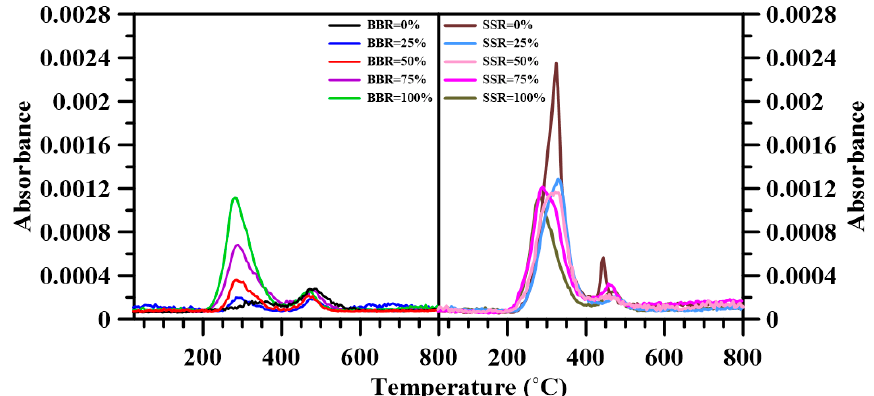
Figure 10. Evolution of CH 4 for various sludge-coal and sludge-shiitake ratios in TGA-FTIR. The CO emission profiles for the individual fuels and their blends are shown in Figure 11. Only one absorption peak was observed for coal and the sludge-coal blends. In contrast, all profiles of the sludge-shiitake blends showed two peaks, in the temperature ranges of 275–400 °C and 425–575 °C, respectively. The first CO peak for sludge was observed at about 341 °C and the second one was observed at about 495 °C. The CO generation of stage 1 and stage 2 was attributed to the decomposition of the volatiles and decarbonylation reaction, respectively. Adding sludge to the blends reduced the absorption value of their peak, which is consistent with the results in Table 5. BBR = 75% yielded the lowest value (0.078). However, adding shiitake to the sludge-shiitake blends increased the CO emission in stage 1, which was compensated with a reduction in CO in stage 2. Overall, CO emission of the blends decreased with shiitake addition to the blends, with SSR = 25% having the lowest gas yield value (0.049).